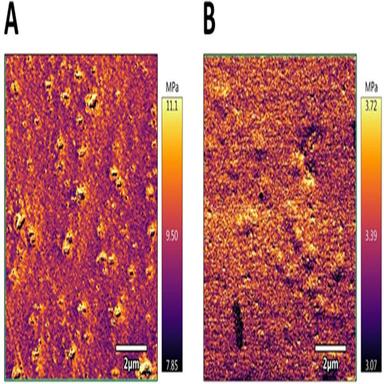
Representative AFM images of IK-ELR (A) and REDV-ELR (B) films. Scale bars: 2 μm. ELR films surfaces were analyzed with an experimental bimodal AFM configuration by using standard AM-FM mode.